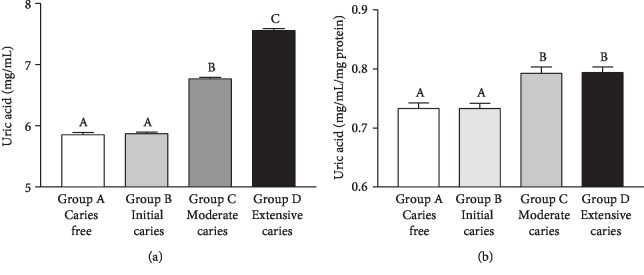
Uric acid (UA) concentration (in mg/mL for the graph in (a) and in mg/mL/mg protein for the graph in (b)) in saliva samples of caries-free children (Group A) and in those with caries at different stages (Groups B-D). Bars represent the mean ± SD. Equal letters represent statistical similarity (p > 0.05) and different letters mean statistical differences (p < 0.001).